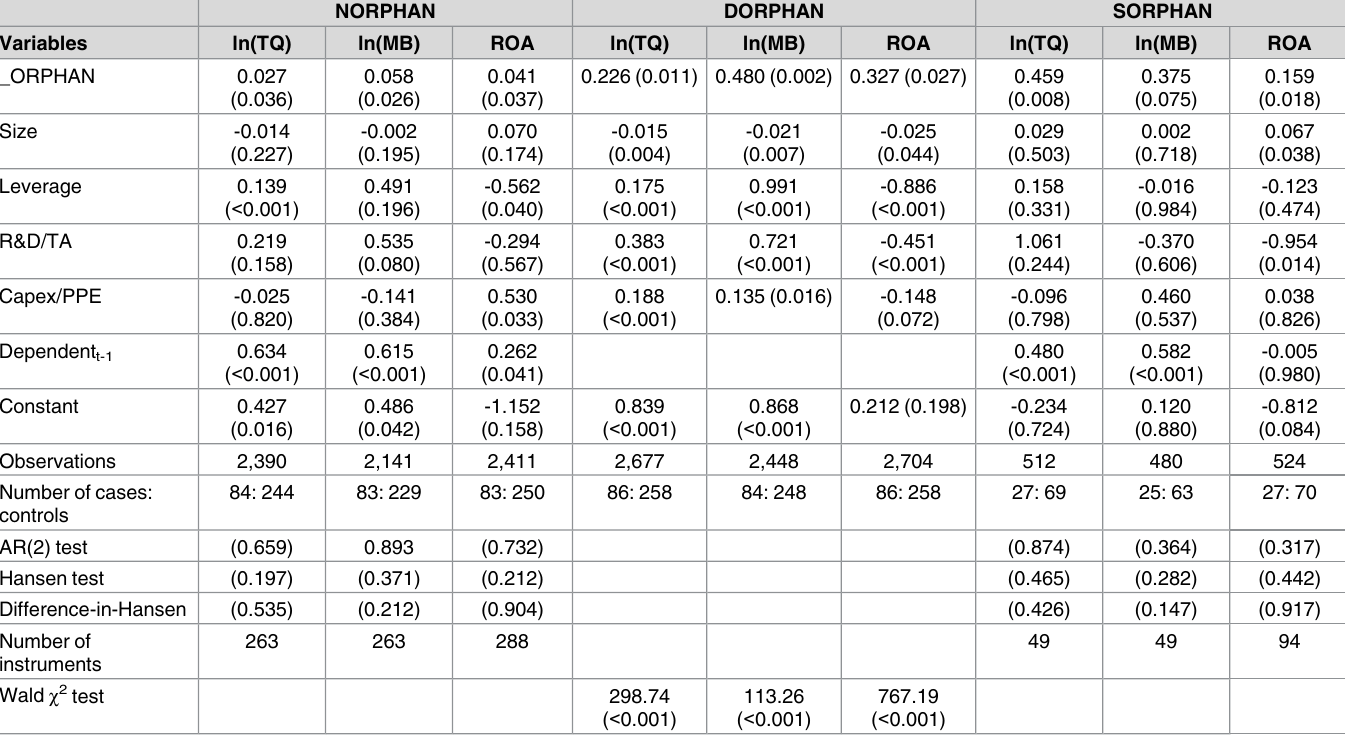
Table 5. Sensitivity analyses using the number of orphans drugs sold per year (NORPHAN), a non-variant orphan dummy (DORPHAN), and the proportion of orphan drug sales to total sales (SORPHAN).